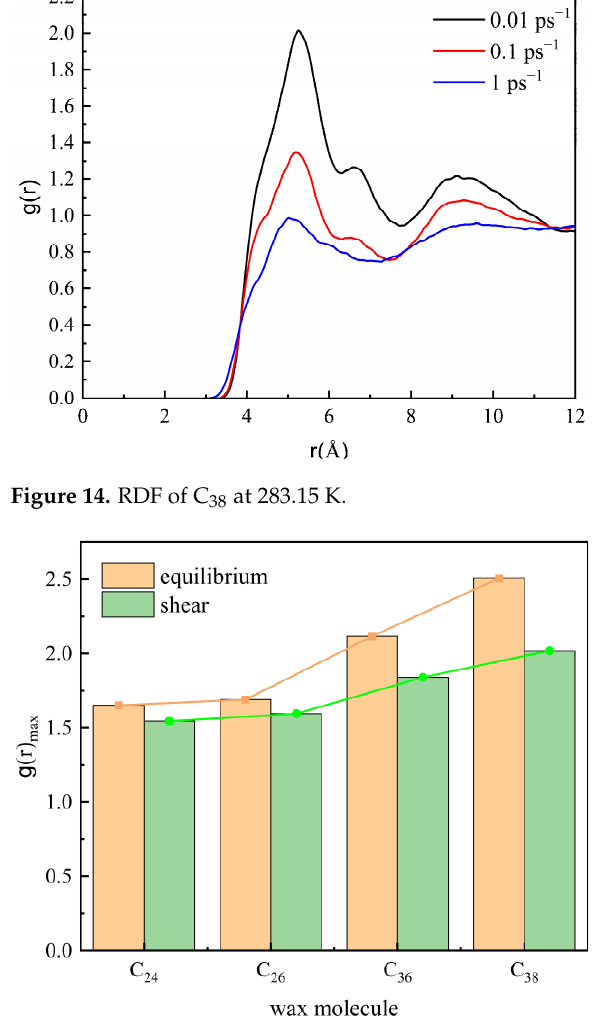
Figure 14. RDF of C 38 at 283.15 K.